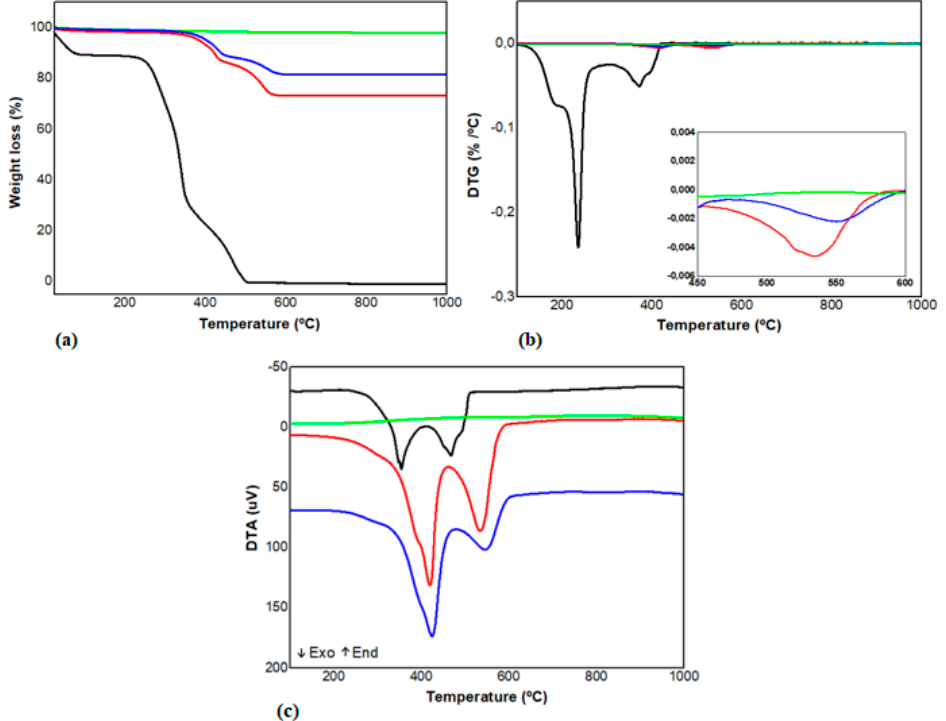
Figure 8. TG ( a ), DTG ( b ), and DTA ( c ) curves: ▬ biomass ▬ fresh catalyst ▬ solid reaction residue at 450 °C ▬ solid reaction residue at 500 °C carried out with air.